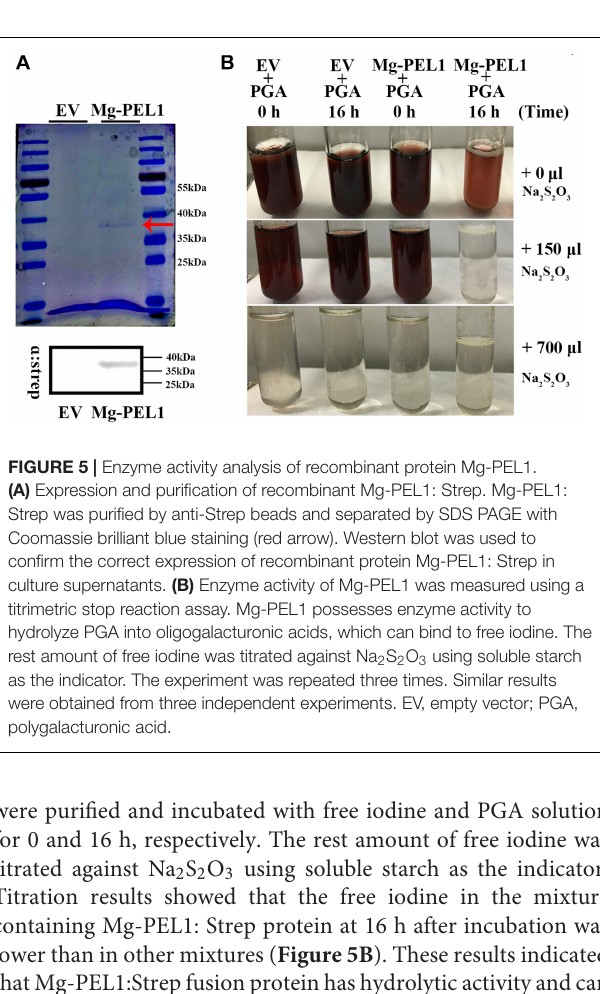
FIGURE 6 | In planta RNA interference (RNAi) of Mg-PEL1 reduces pathogenicity of Meloidogyne graminicola . (A) Semi-quantitative PCR for the detection of the β -glucuronidase (GUS) intron fragment was used to confirm the expression levels of RNAi construct in roots of transgenic RNAi lines. Three independent samples from different plants of WT, RNAi10 and RNAi28 were used for the analysis. The experiment was repeated three times. OsUBQ (Os03g13170) gene was selected as the reference gene for semi-quantitative PCR. (B) qRT-PCR assays of the expression levels of Mg-PEL1 in M. graminicola collected from RNAi lines and WT at 3 day post-inoculation (dpi). The expression levels of MgCRT and MgExpansin from M. graminicola were used to determine the specificity of the Mg-PEL1- targeting RNAi. Similar results were obtained from three independent experiments. (C) Transgenic RNAi lines showed a significant reduction in the number of adult females compared with the WT. Two-week-old seedlings were inoculated with M. graminicola pre-J2s, and the number of adult females per plant was counted at 15 dpi. Data are presented as the means ± standard deviation (SD) from 9 to 10 plants. Two independent experiments were performed with similar results. All data revealed normal distribution and homogeneity of variance. One-way ANOVA Dunnett’s t -tests, * P < 0.05; ** P < 0.01. RNAi10 and 28, different RNAi transgenic rice lines. WT, wild